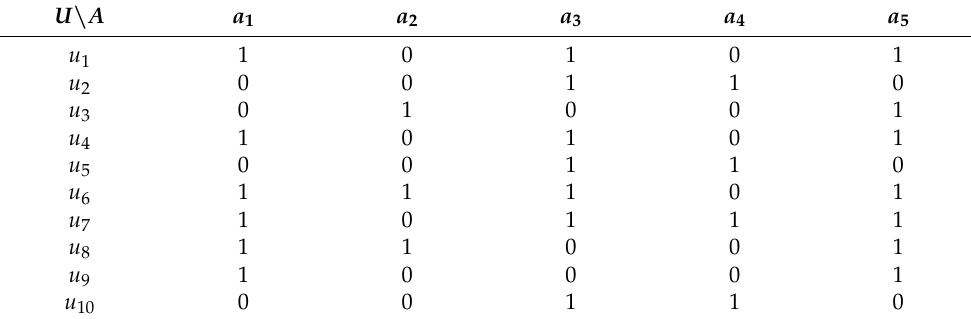
Table 3. A transactional database A = ( U , A ) .